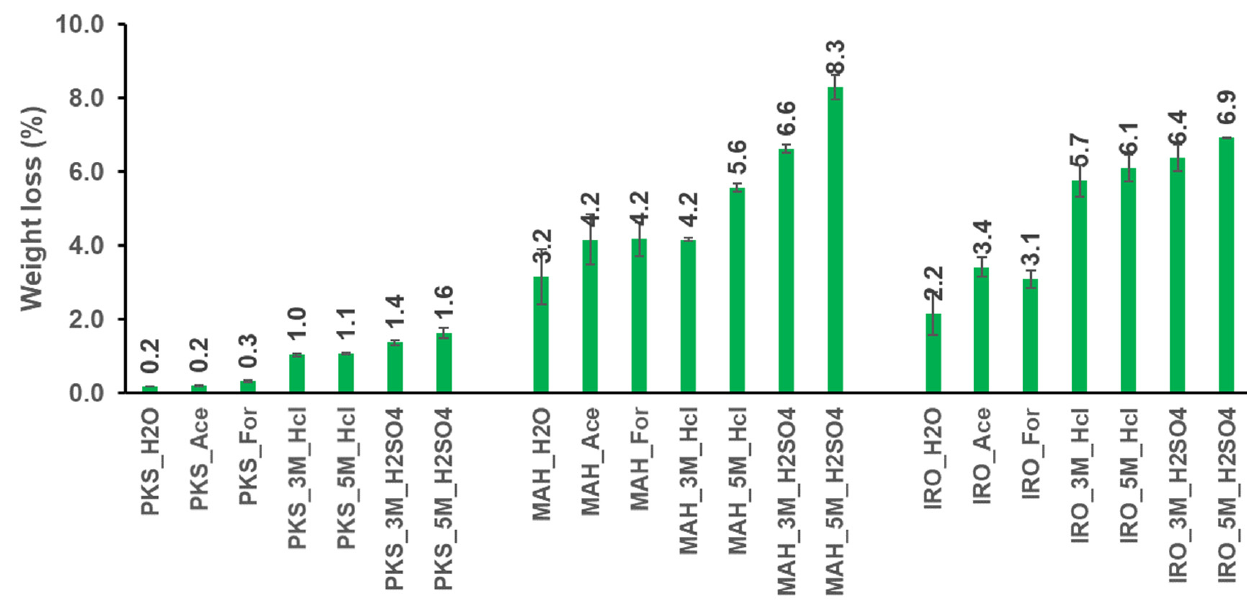
Figure 1. Percentage of weight loss after pretreatment of palm kernel shell (PKS), mahogany (MAH) and iroko (IRO) sawdust.